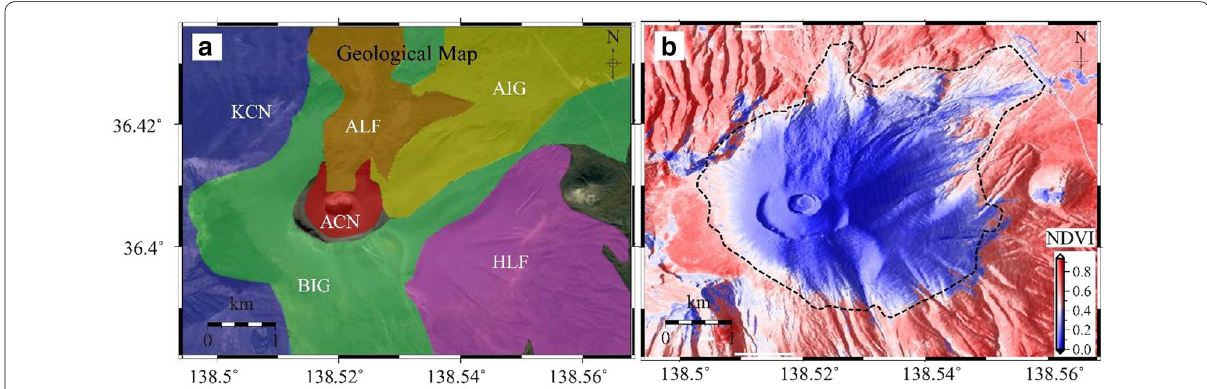
Fig. 2 The geological map ( a ) and the Normalized Difference Vegetation Index (NDVI) map ( b ) around Asama volcano. The annotations in ( a ) indicate different types of geological deposits, namely, KCN Kurofu cone formed about 24,000 years ago, HLF Lava of Hotokeiwa cone formed about 11,000 years ago, BIG Oiwake ignimbrite formed during the 1108 explosive eruption, ACN Kamayama scoria cone, ALF Oni Oshidashi lava flow, AIG Agatsuma ignimbrite. All the ACN, ALF, and AIG were formed during the 1783 eruption. The blue and red color in b indicate the increase in Vegetation Coverage